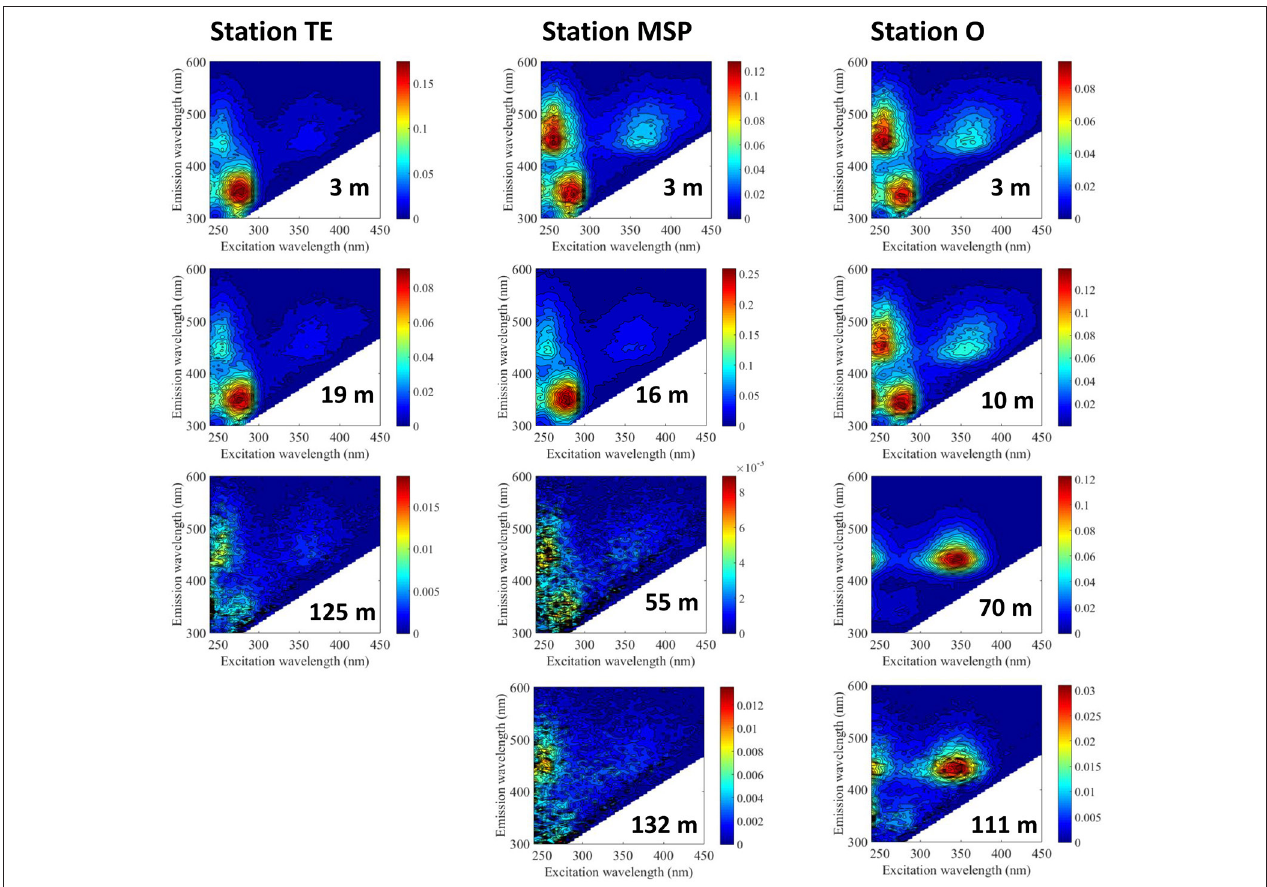
FIGURE 3 | Excitation-emission matrices (EEMs) of base-extracted POM (BEPOM). Note the difference in scale among stations and depths. EEMs of Stn. O (3 and 111m) were previously shown in Brym et al. (2014) (see Brym et al.’s Figures 4E,F).